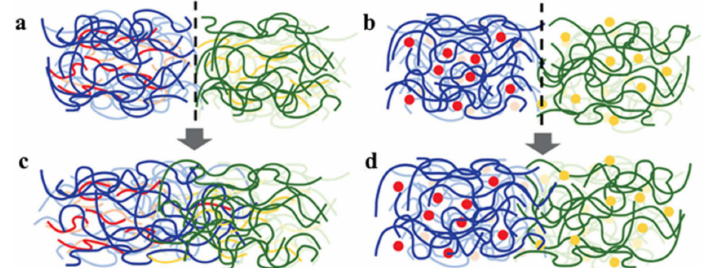
Figure 63. Schematic diagrams of PU / epoxy oligomer ( a ) before and ( b ) after healing and PU / epoxy with bis(4-maleimidophenyl)methane ( c ) before and ( d ) after healing. Reproduced from [268] with permission from John Wiley and